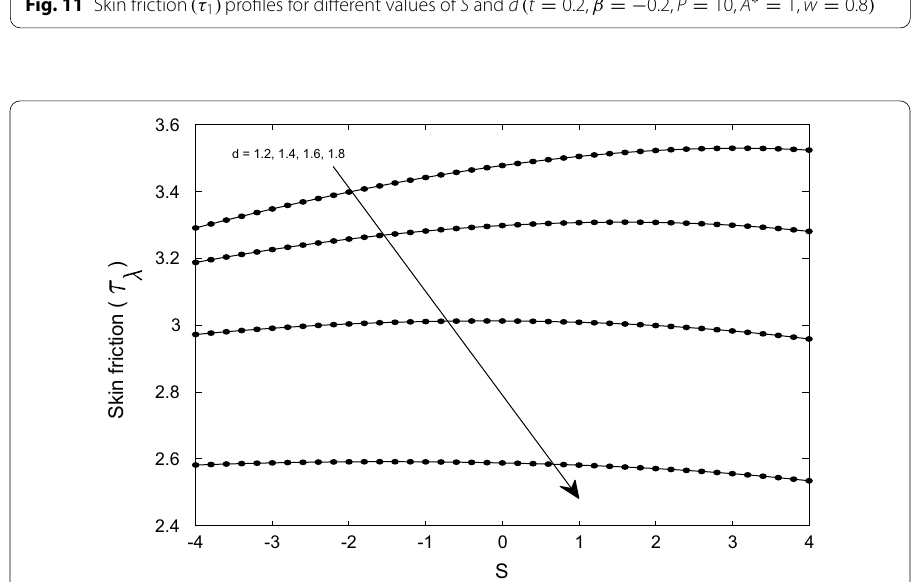
Fig. 12 Skin friction (τ (cid:31) ) profiles for different values of S and d ( t